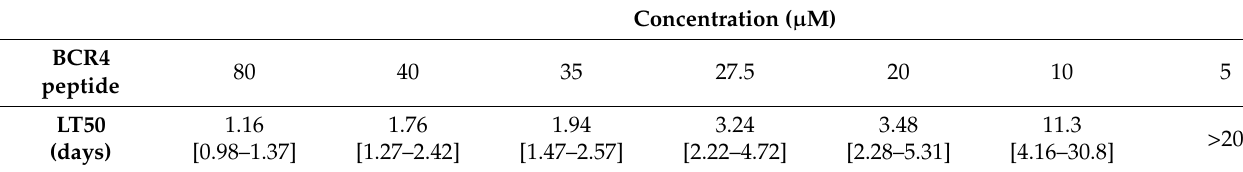
Table 2. Toxicity of BCR4 peptide on the pea aphid Acyrthosiphon pisum (mean values of Lethal Time 50 (LT50) in days, with confidence intervals), analyzed by survival analysis with a log-normal fit.